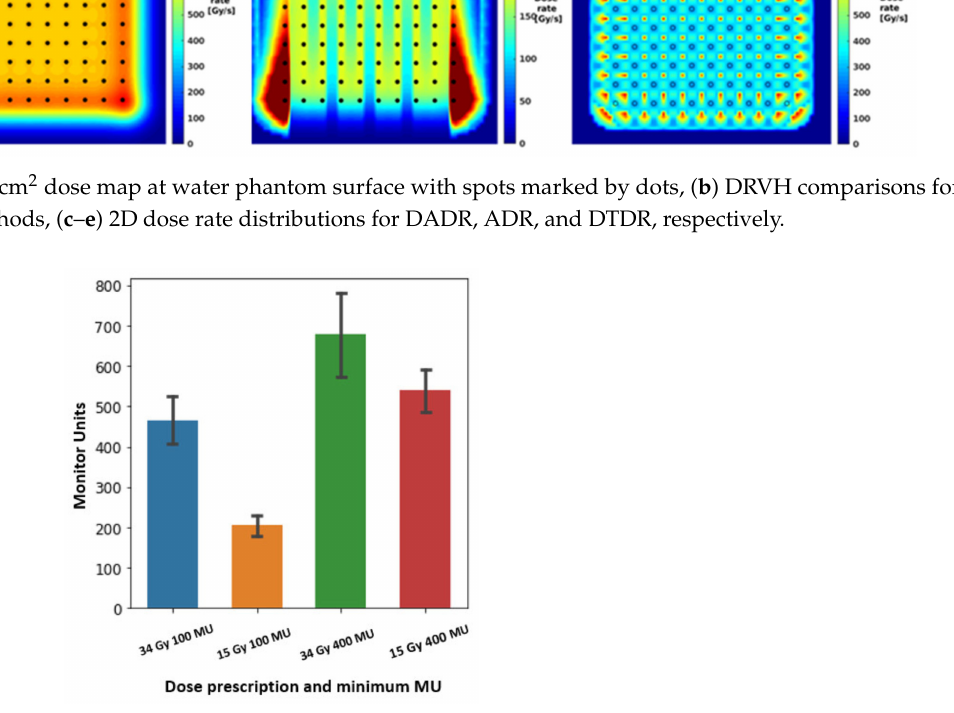
Figure 4. The MU statistics of spots for one patient using two different prescriptions (15 Gy × 3 fractions and 34 Gy × 1 fraction) and two minimum MU/spot settings: the bar height represents the mean MUs of one plan. The error bar represents the MU standard deviation from the mean